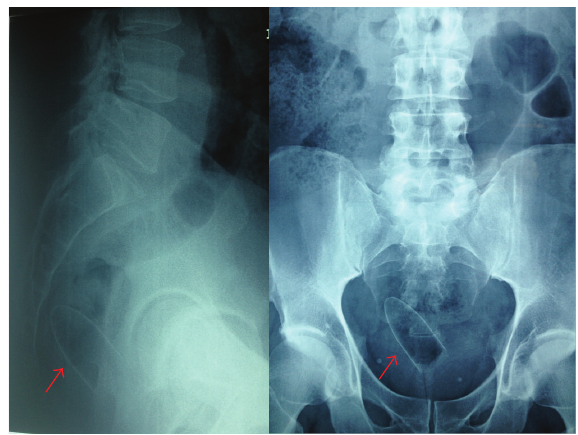
Figure 1: Plain radiographs of the pelvis outline a foreign body within the rectum (indicated by red arrow) that has a cylindrical shape and a tapered tip.